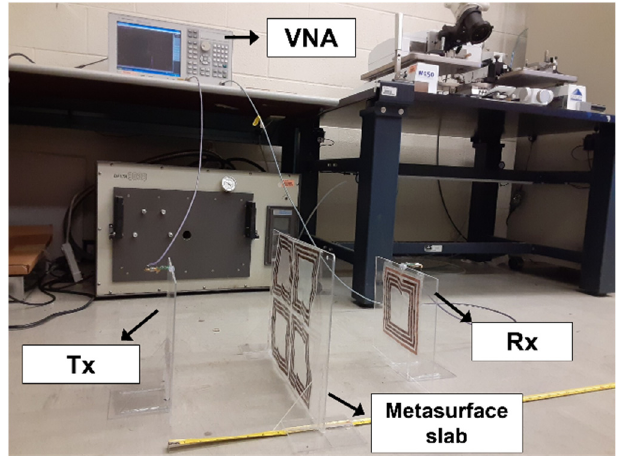
Figure 11. Measurement setup.